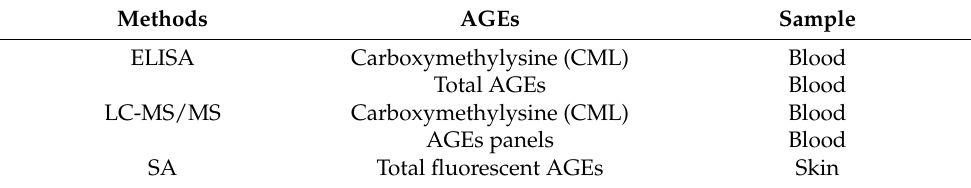
Table 2. Characteristics of the main analytical methods currently used for AGEs quantification.